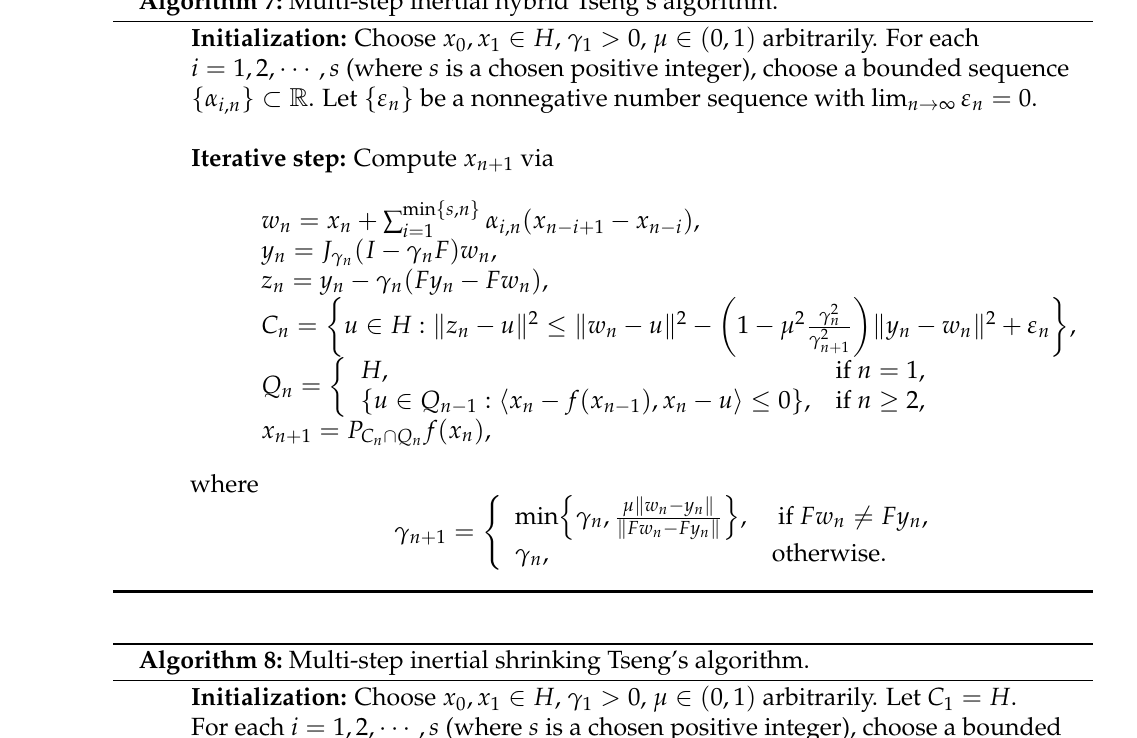
Algorithm 7: Multi-step inertial hybrid Tseng’s algorithm.